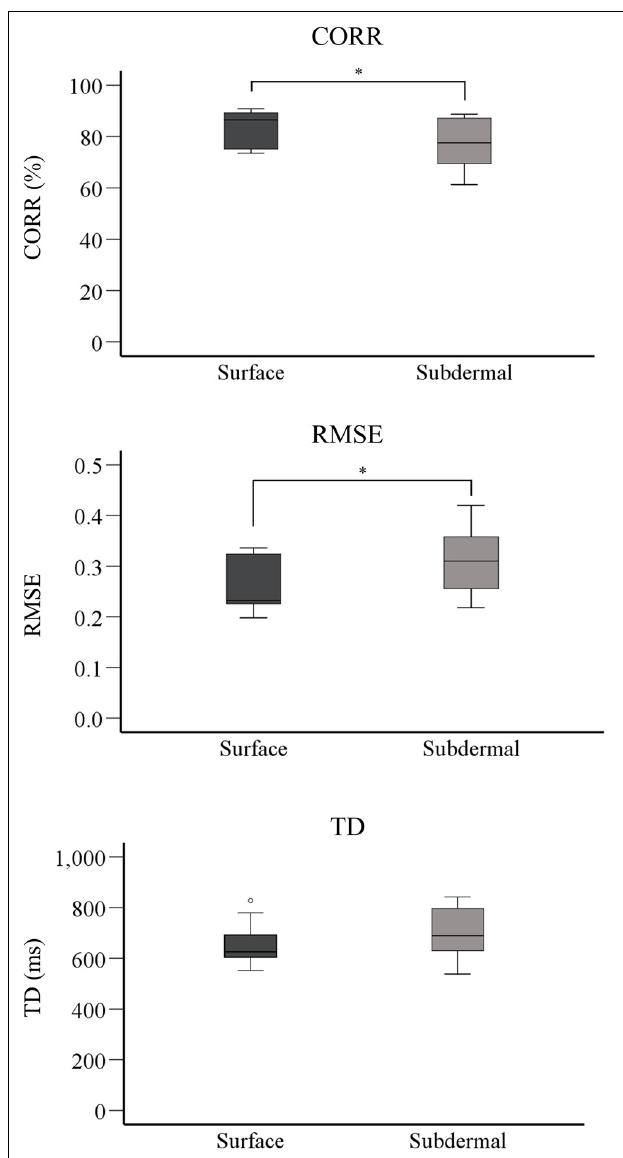
FIGURE 4 | Boxplots showing summary performance for CORR, RMSE, and TD for the last 5 tracking trials (steady-state). The horizontal line is the mean value, the box indicates interquartile range, and whiskers are minimum and maximum values. The symbol * indicates a statistically significant difference ( p < 0.05). RMSE, root mean square error; CORR, correlation, TD, time